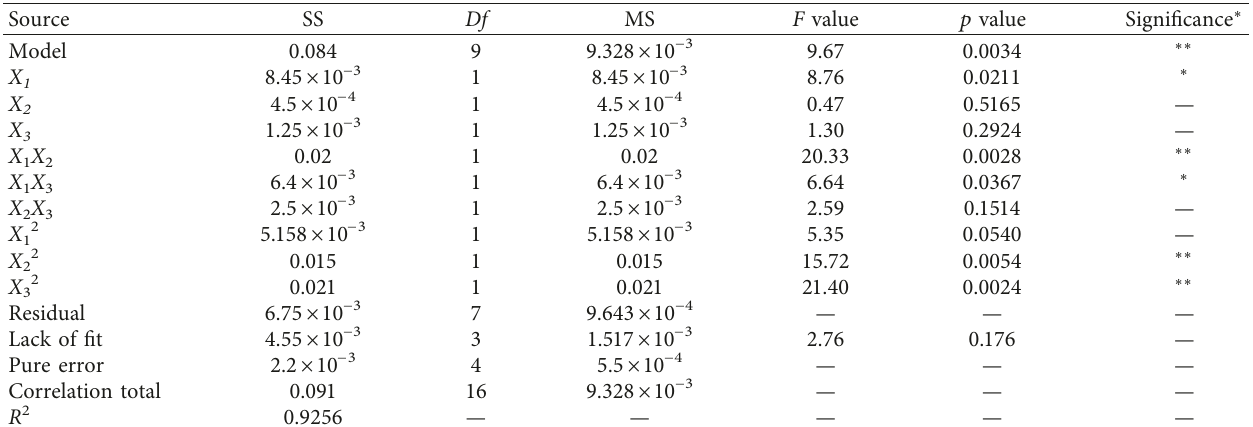
Figure 4: Effects of reaction time on wet shear strength. Table 3: Variables and levels used in RSM